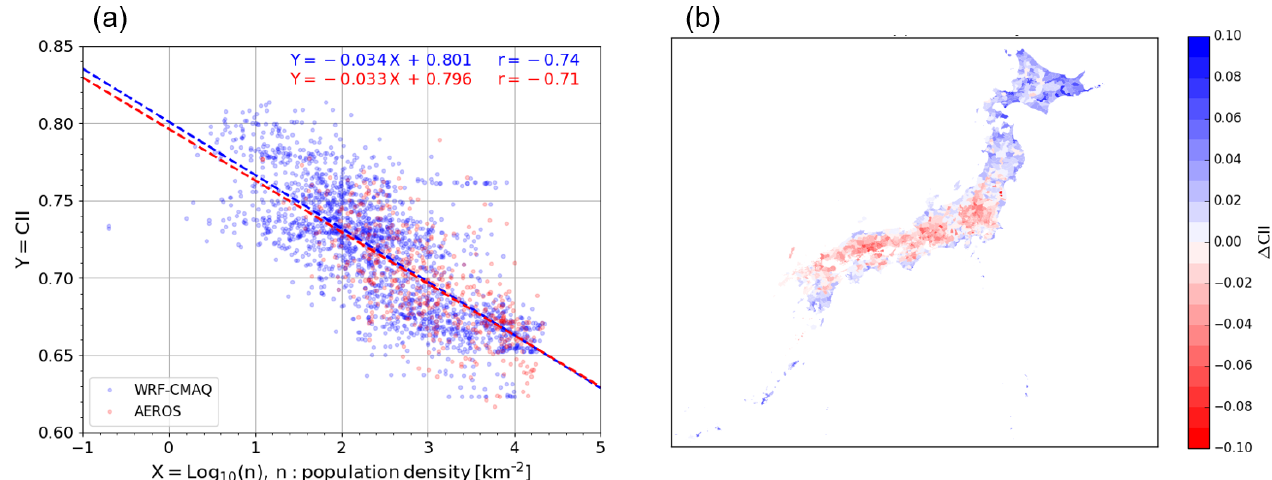
Figure 9. (a) Comparison of CII and population density ( n ) in each Japanese municipality. The dashed line shows the linear regression of CII with log 10 ( n ). The correlation coefficient ( r ) between CII values and log 10 ( n ) is also shown in the upper corner. The blue and red coloring shows the WRF–CMAQ and AEROS results, respectively. (b) Distribution of differences in CII from the linear regression ( (cid:49) CII) for the WRF–CMAQ